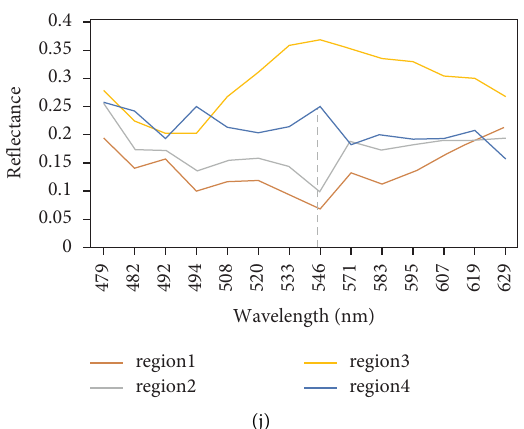
Figure 10: Drosophila and fruit hyperspectral imaging results and analysis. (a)–(h) Drosophila and fruit images from 8 selected spectral channels. (i) Color image recovered from 16 spectral channels. (j) Representative spectra from the 4 regions labeled in